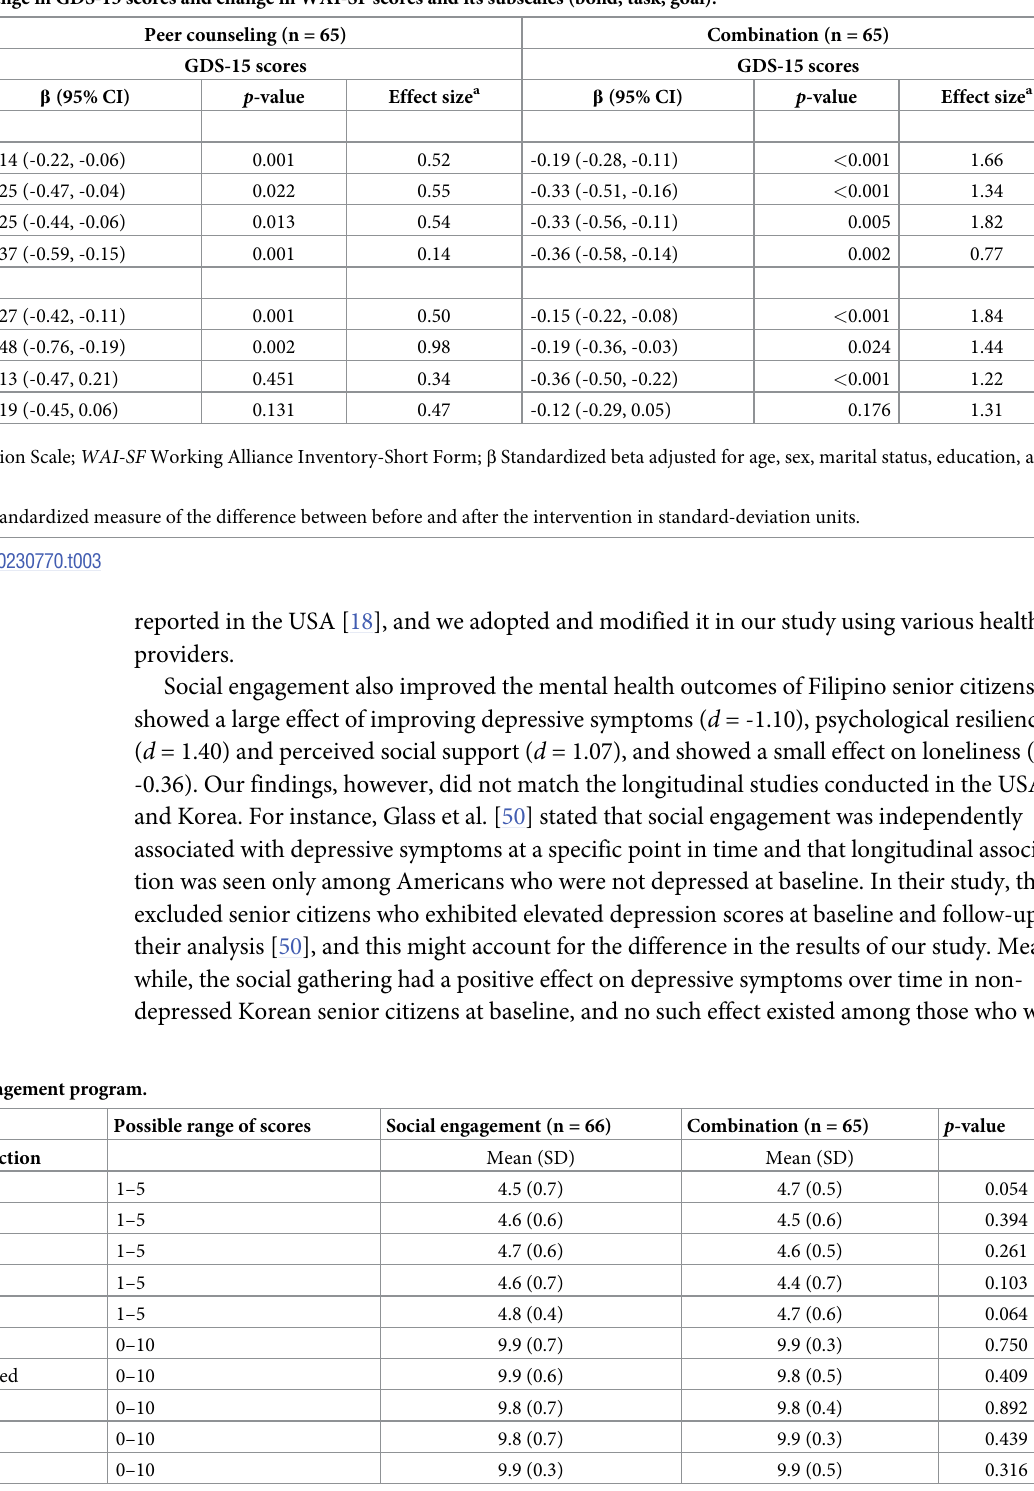
Table 3. Association between change in GDS-15 scores and change in WAI-SF scores and its subscales (bond, task, goal).